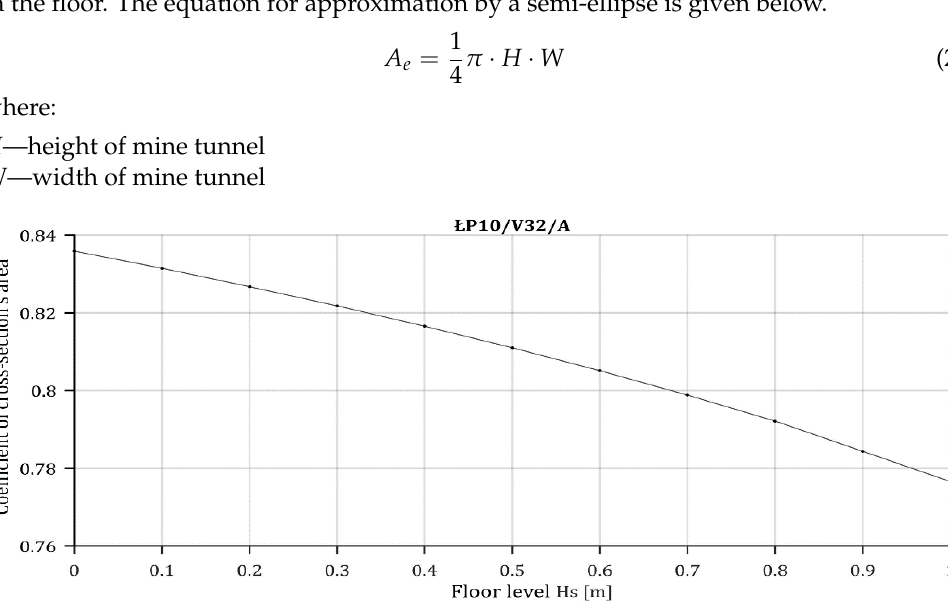
Figure 10. Change of cross-sectional shape coefficient as a function of floor height [13].